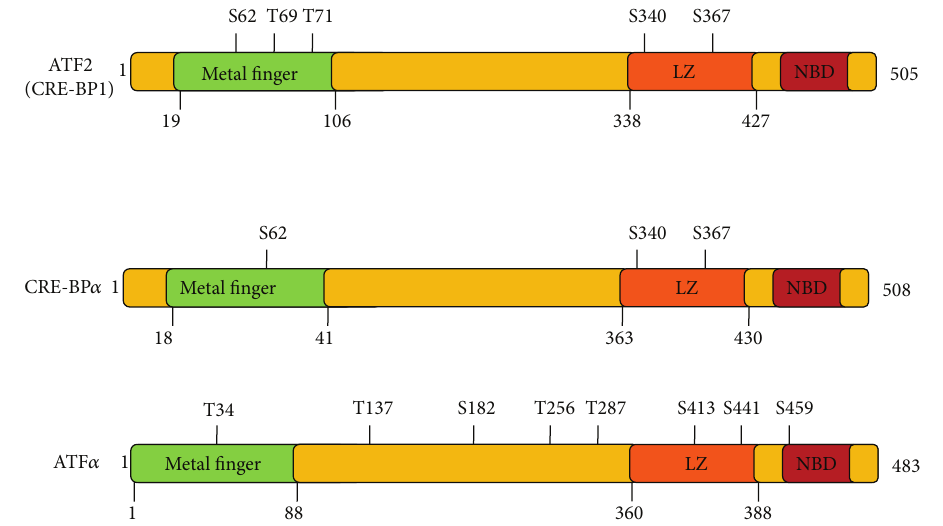
Figure 1: Characteristics of ATF proteins. ATF: activating transcription factor; LZ: leucine zipper; NBD: nucleotide-binding domain.